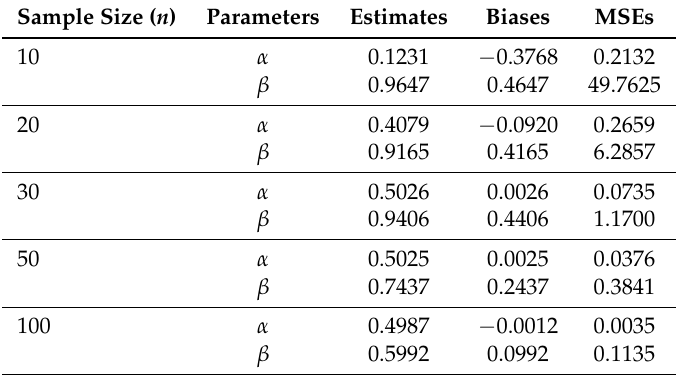
Table 4. Estimates, biases and MSEs for α = 0.5 and β = 0.5.